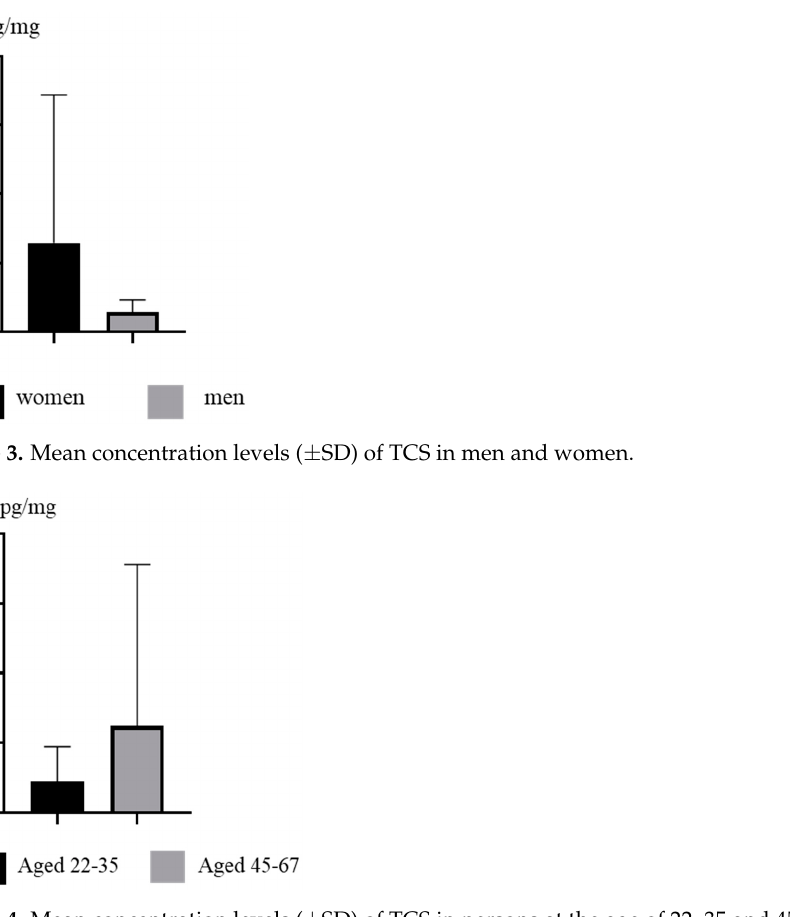
Figure 4. Mean concentration levels (±SD) of TCS in persons at the age of 22–35 and 45–67.